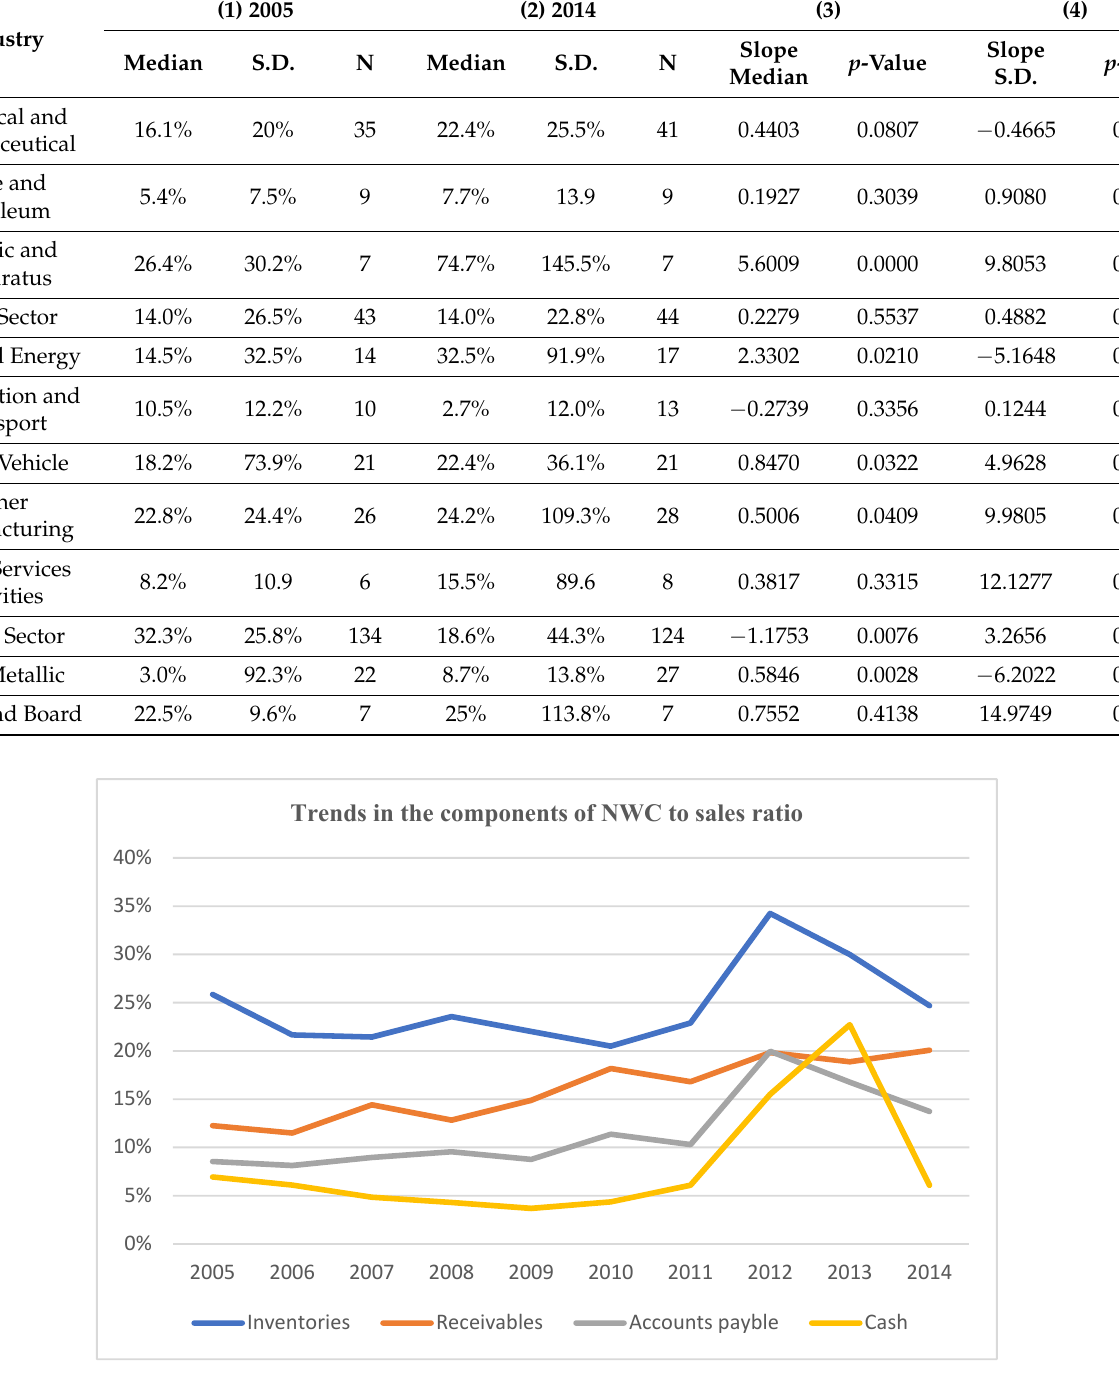
Figure 1. Yearly average of inventories, account receivables, and account payables. This figure shows the year-wise cross-sectional average for inventories, receivables, and payables scaled by sales for non-financial Pakistani firms from 2005 to 2014.